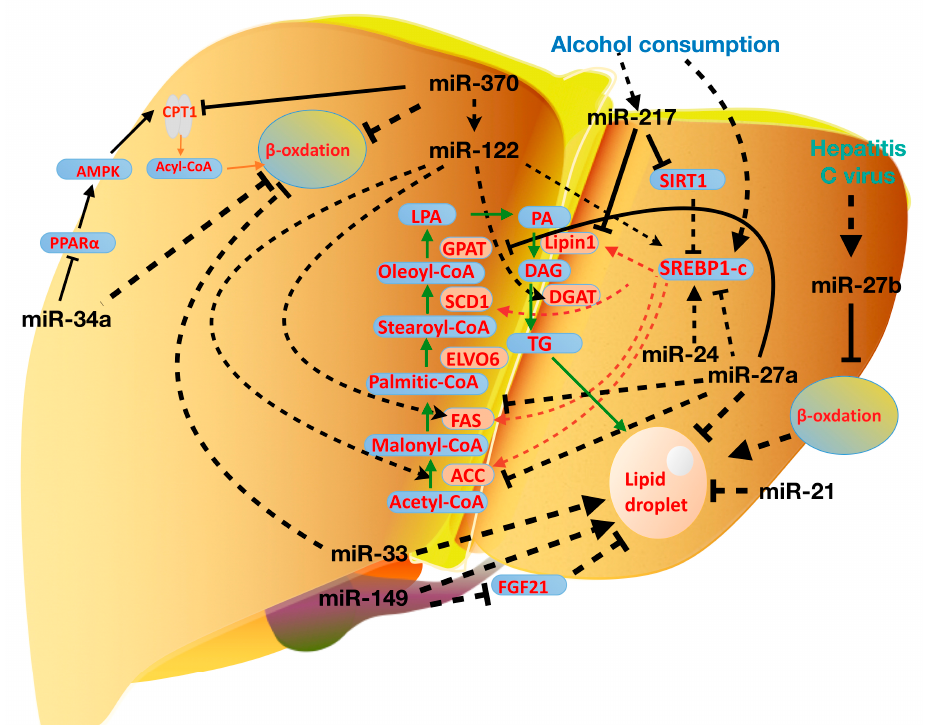
Figure 4. Roles of some miRNAs in fatty liver diseases: miR-122 is a NAFLD related miRNA, which can target many genes in the process of lipogenesis; alcohol consumption stimulate miR-217 expression and then induced lipid accumulation; hepatitis promotes hepatic lipid accumulation through inducing miR-27 expression. The green arrow is used to illustrate the direction of lipogenesis.